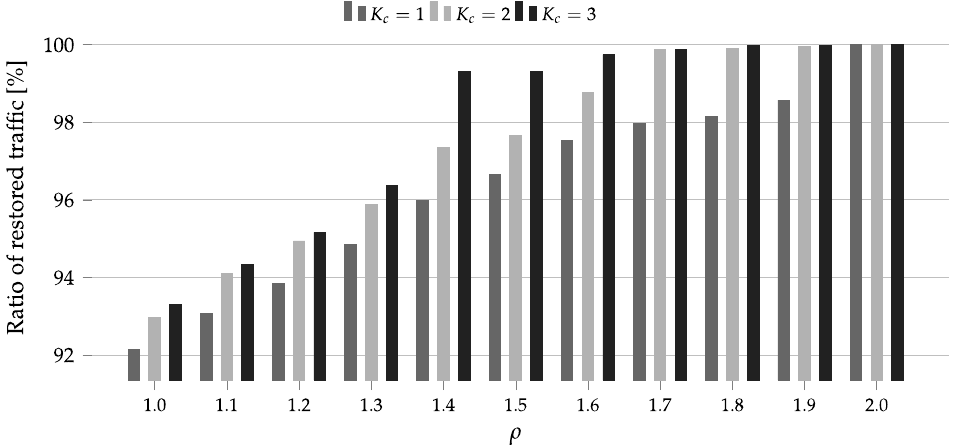
Figure 5. Ratio of the restored traffic for PL12 and 25 Tbps as a function of the amount of additional resources ρ